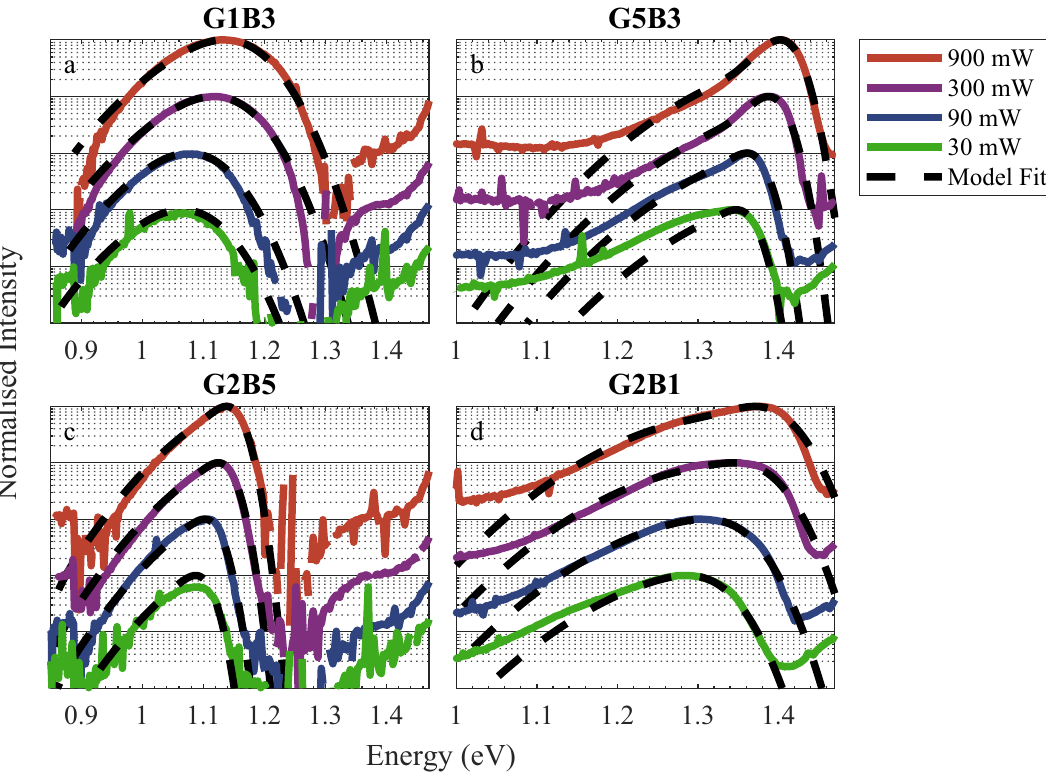
Figure 3. PL spectra at 30 K and model fits for devices grown at the limits of growth temperature and bismuth flux. ( a ) G1B3 grown at 355 °C and ( b ) G5B3 grown at 405 °C both under the same bismuth BEP of 1.06 × 10 – 7 mbar. ( c ) G2B5 grown under a bismuth BEP of 2.12 × 10 –7 mbar and ( d ) G2B1 grown under a bismuth BEP of 0.5 × 10 –7 mbar, both grown at 375 °C.